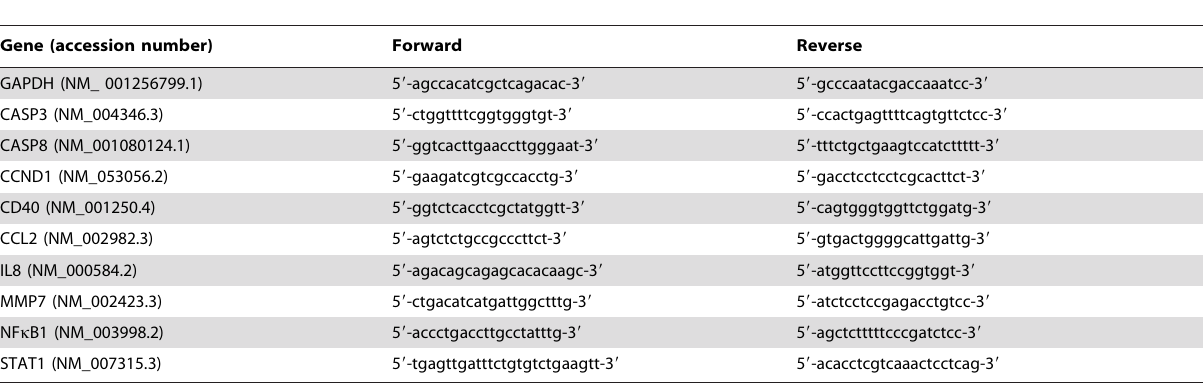
Primers are shown for genes that are discussed in the paper beyond cell-screening experiments.